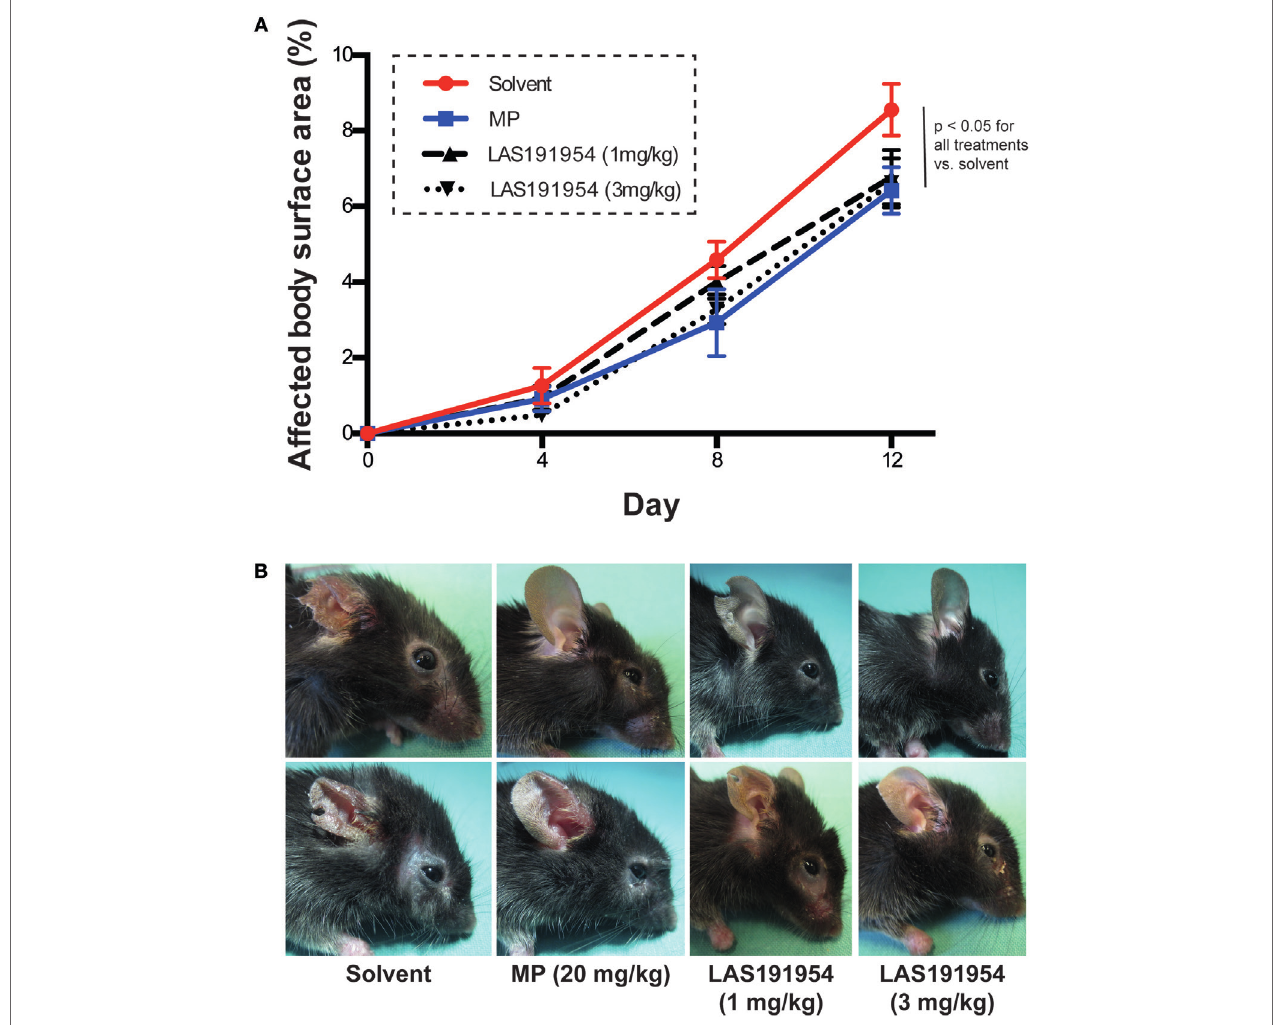
FigUre 3 | LAS191954 treatment prevents the onset of antibody transfer-induced Epidermolysis bullosa acquisita (EBA). Experimental EBA was induced in B6 mice by repetitive injections of anti-COL7 IgG. Simultaneously, mice were treated with the indicated compounds. (a) In all groups, experimental EBA was induced. Data are based on 10 mice per group. Statistical analysis was performed using two-way ANOVA (taking time and treatment as variables) with Holm-Sidak posttest. (B) Representative clinical images of two mice from each group taken at the end of the